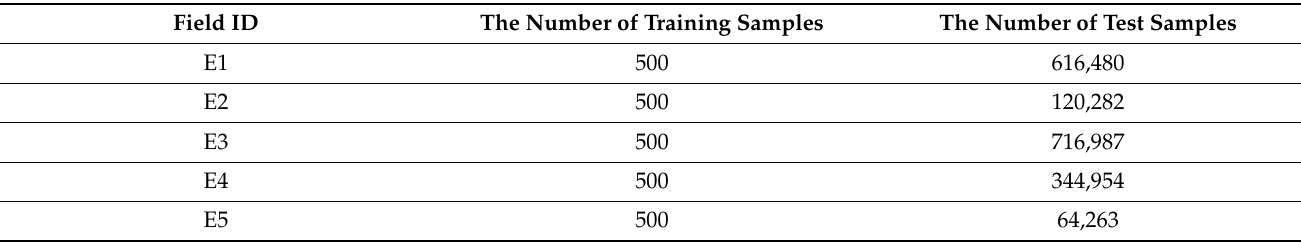
Table 7. The number of training and test samples.